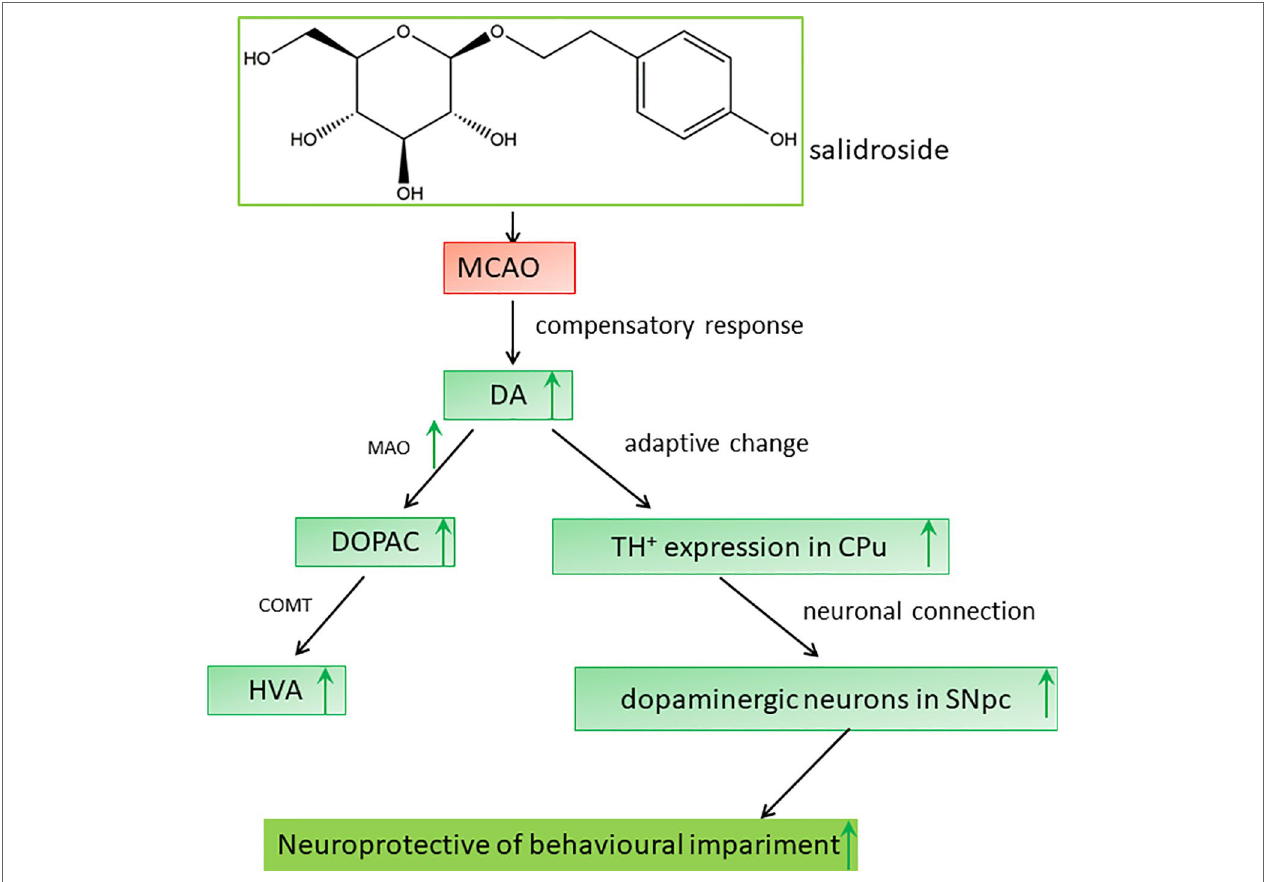
FIgURE 8 | Proposed mechanisms of the effect of salidroside in MCAO rats. Salidroside attenuates MCAO-induced neurobehavioral impairment by increasing the levels of DA, DOPAC, HVA, and MAO and elevating TH-positive expression in the CPu and SNpc. CPu striatal caudate putamen, DA dopamine, DOPAC 3,4-dihydroxyphenylacetic acid, HVA homovanillic acid, MAO monoamine oxidase, MCAO middle cerebral artery occlusion, SNpc substantia nigra pars compacta, TH tyrosine hydroxylase.